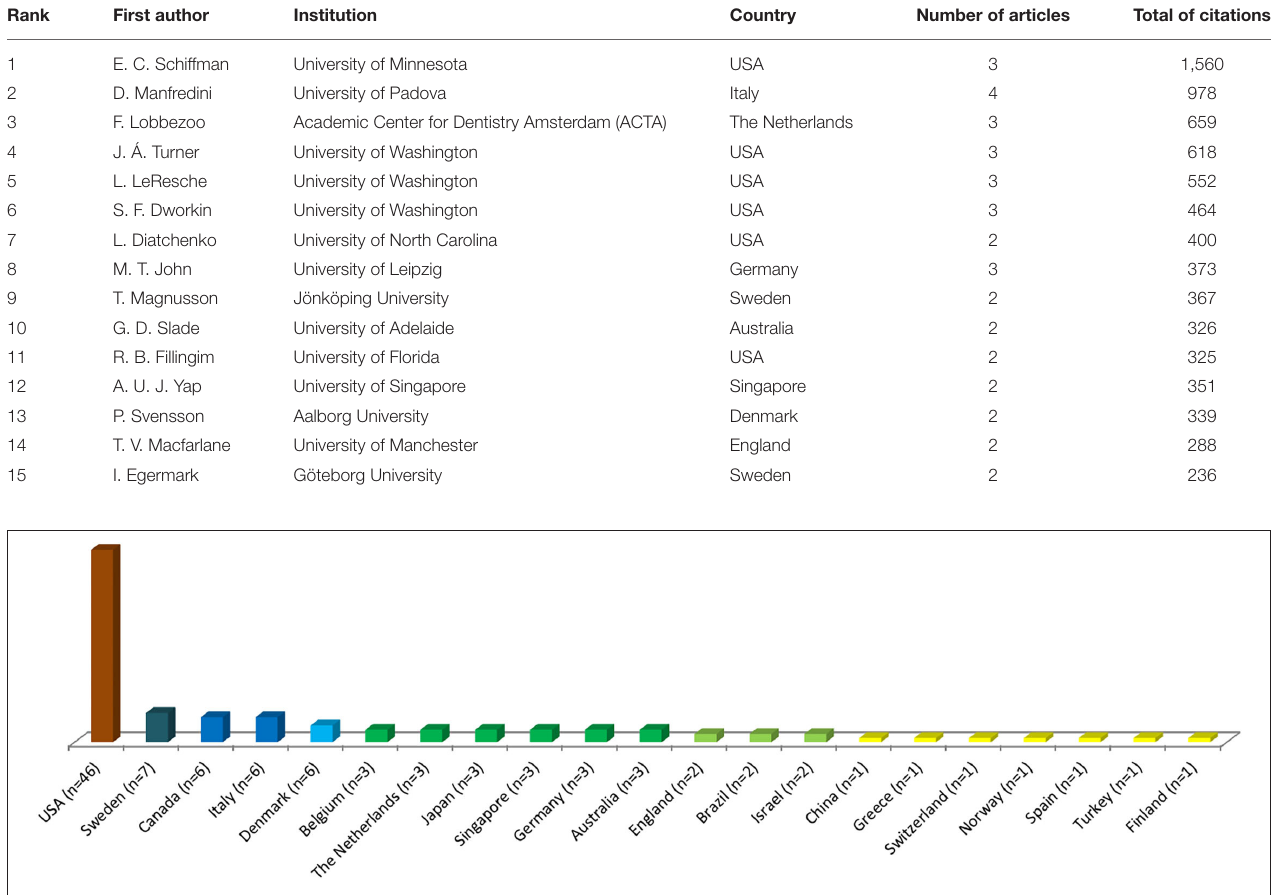
FIGURE 1 | Number of top 100 cited studies in the field of temporomandibular disorders published per country from 2000 to